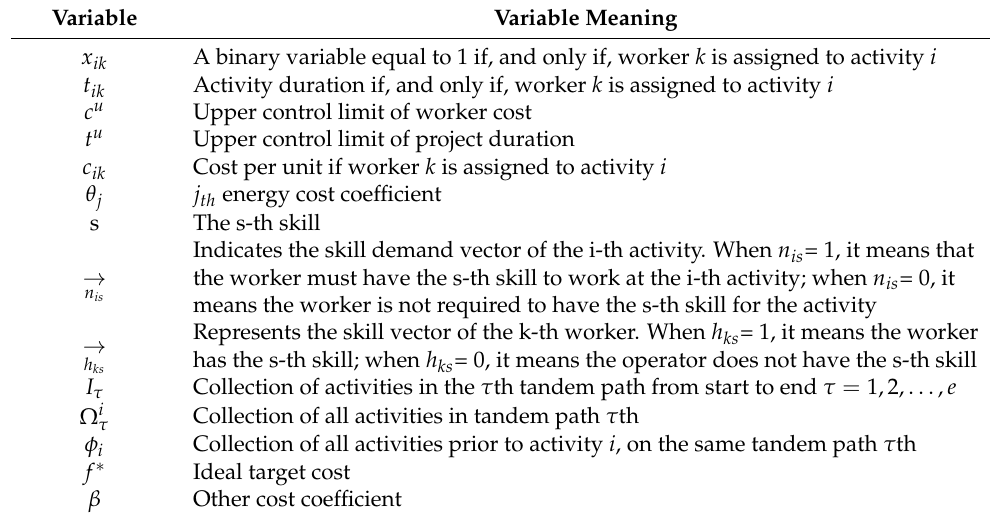
Table 1. Mathematical symbol and their